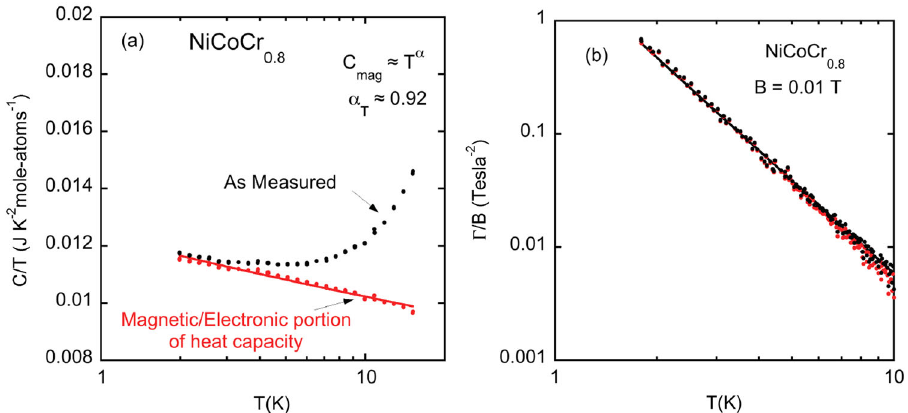
Fig. 4 Heat capacity data and illustration of divergence of magnetic Gruneisen coef fi cient a Heat capacity data divided by temperature vs log T. The lattice contribution is estimated using a NiCoCr 1.2 alloy and it is subtracted from the total measured heat capacity for NiCoCr 0.8 resulting in the data shown in red . This alloy is a Pauli paramagnet outside of the critical region (see Fig. 2) that should have a very similar phonon contribution to the heat capacity. 19 The low temperature heat capacity of the reference alloy, NiCoCr 1.2 , is well described by a Debye model with an electronic contribution characterized by γ = 9.2 mJ/mole-K 2 , and Θ D = 466 K. b log ( Γ ) vs. log (T), with a solid line illustrating the divergence of Γ ≈ T − 2.5 . The standard deviation (s.d.) for these data are approximately the size of each data point